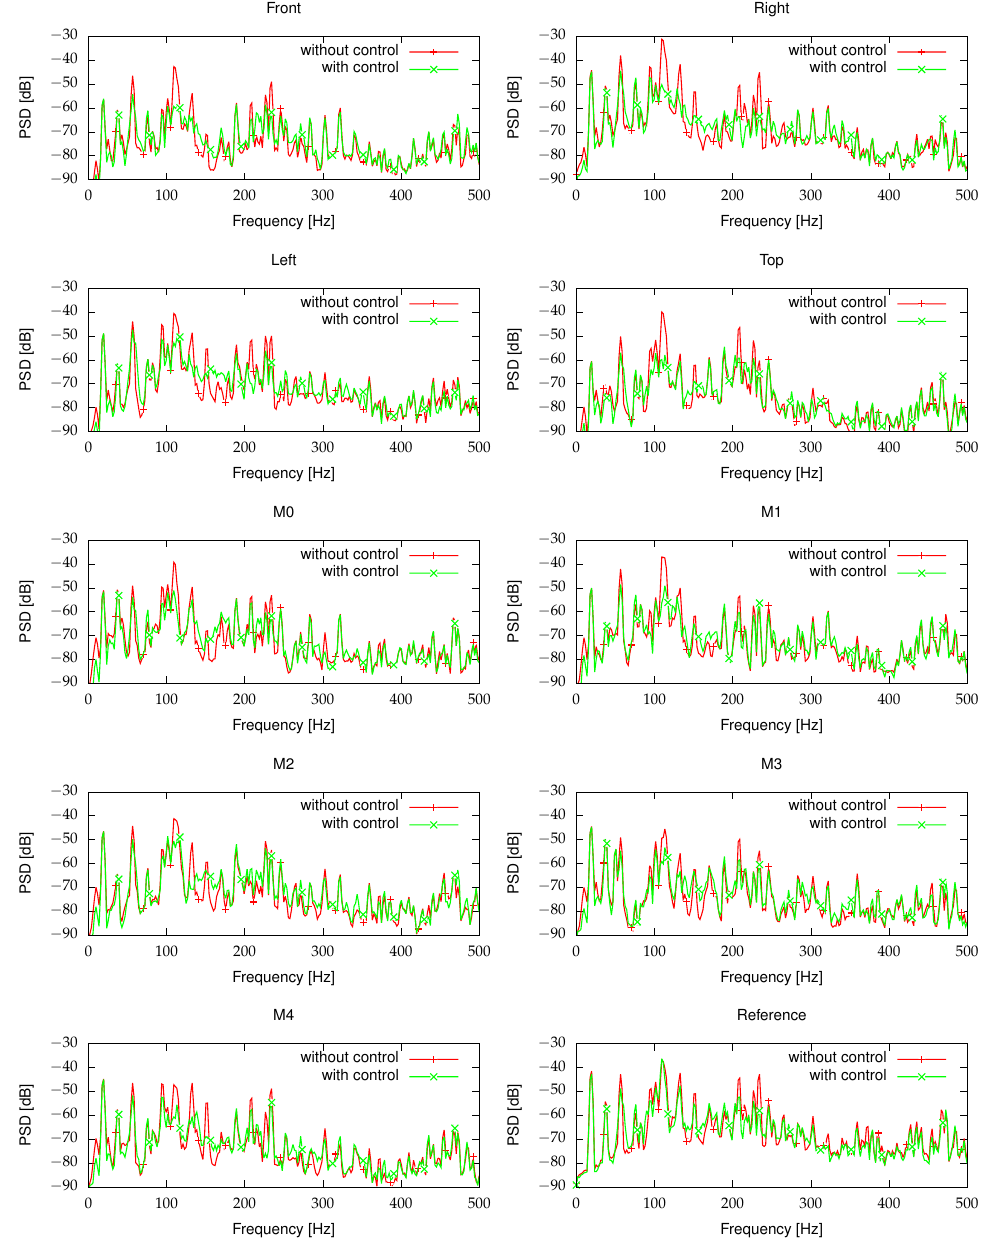
Figure 8. Power spectral densities of signals from microphones for spinning at 1200 rpm.